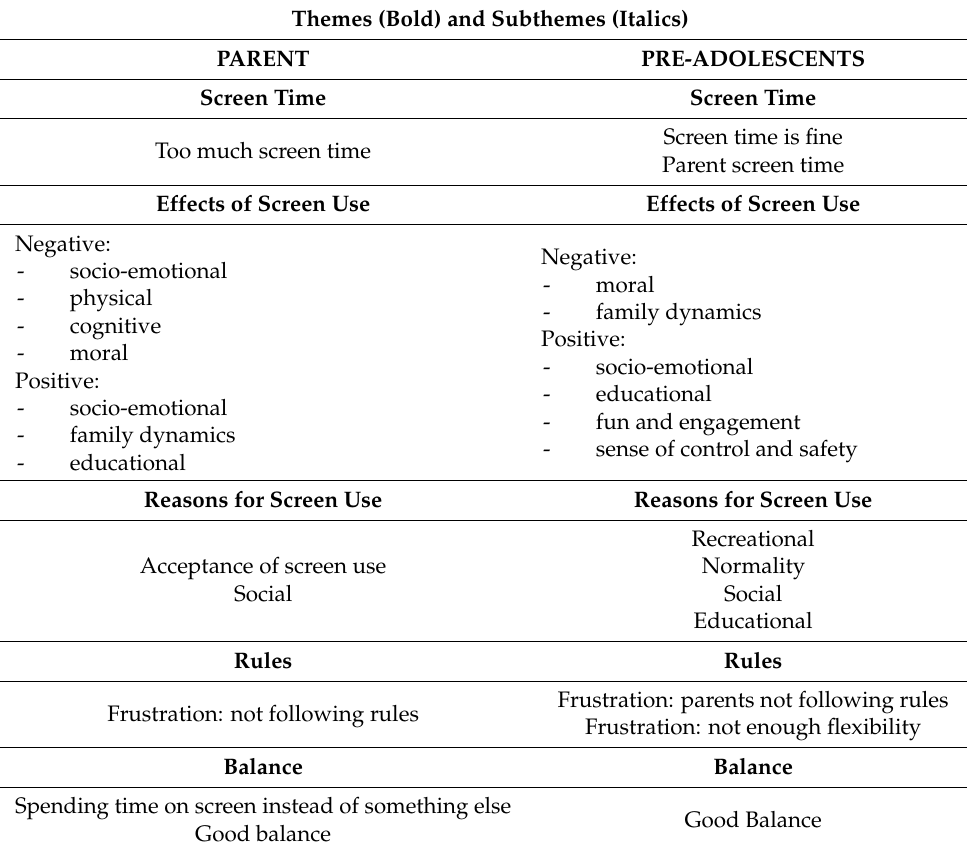
Table 2. Parental and pre-adolescent perceptions of screen-use. Themes (Bold) and Subthemes